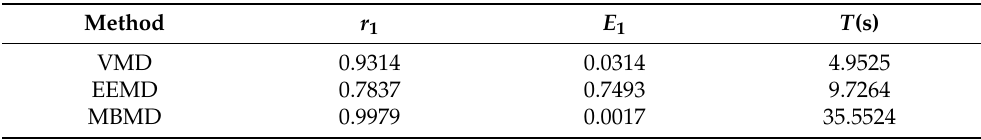
Figure 17. MBMD decomposition diagram under the noise of SNR 5. ( a ) DC signal; ( b ) Wideband signal; ( c ) Narrowband signal; ( d ) Harmonic signal; ( e ) Noise signal; ( f ) A 0.1 s signal extract from ( d ). Table 2. Evaluation parameters of the three algorithms (SNR 10).